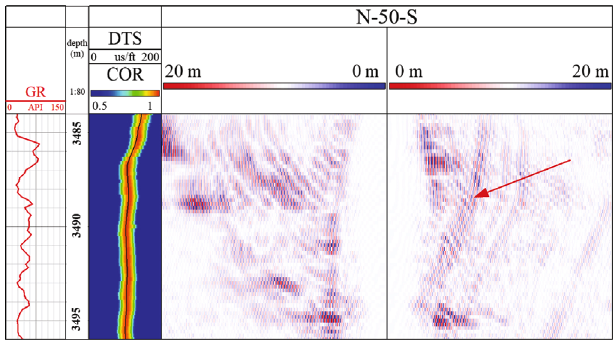
Figure 6: The pro fi le migration imaging of north to south 50 °